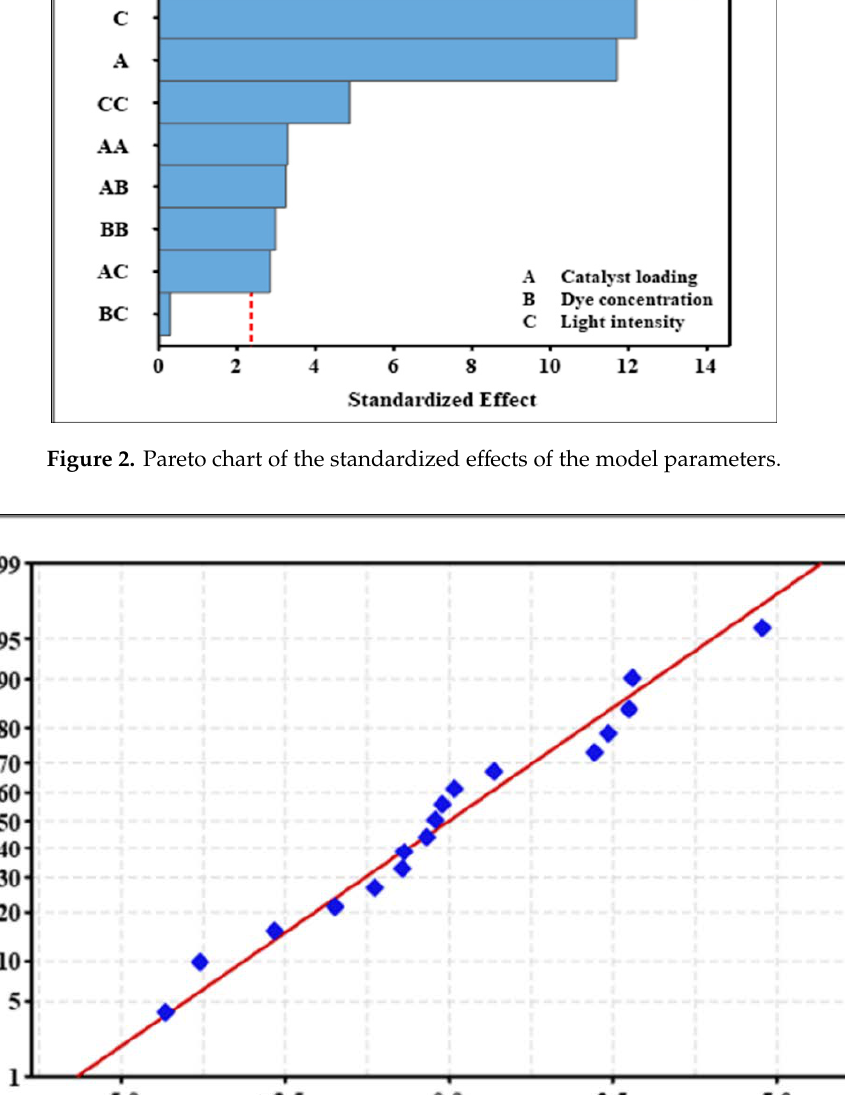
the standardized e ff ects of the model